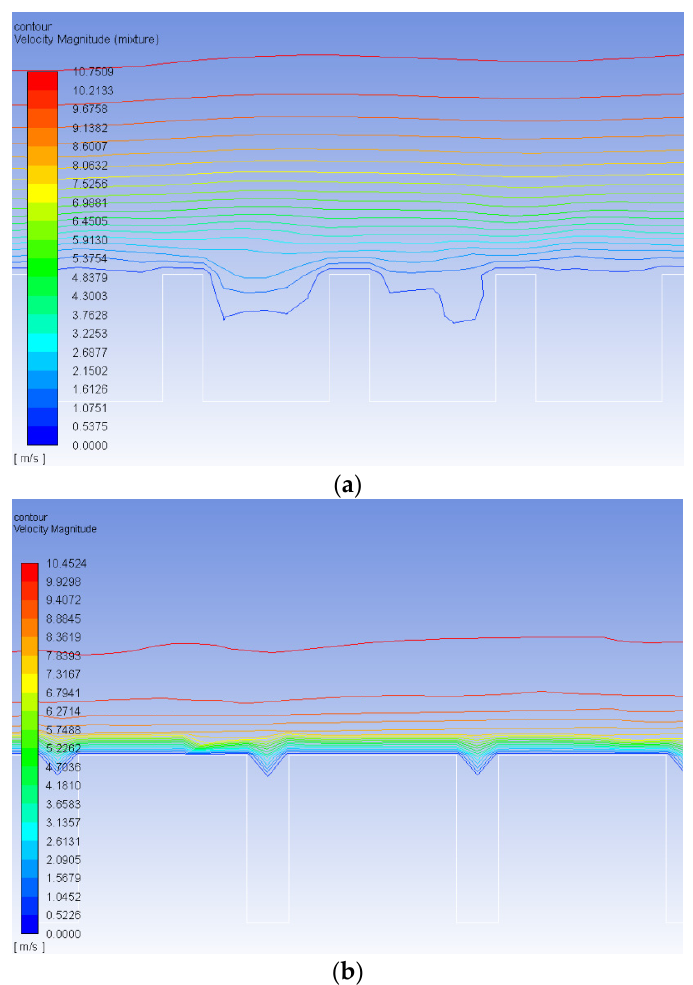
Figure 3. The velocity contour of various slip surfaces (VOF model, 250,000 steps in FLUENT). ( a ) θ r = 154°; ( b ) θ r = 84°.